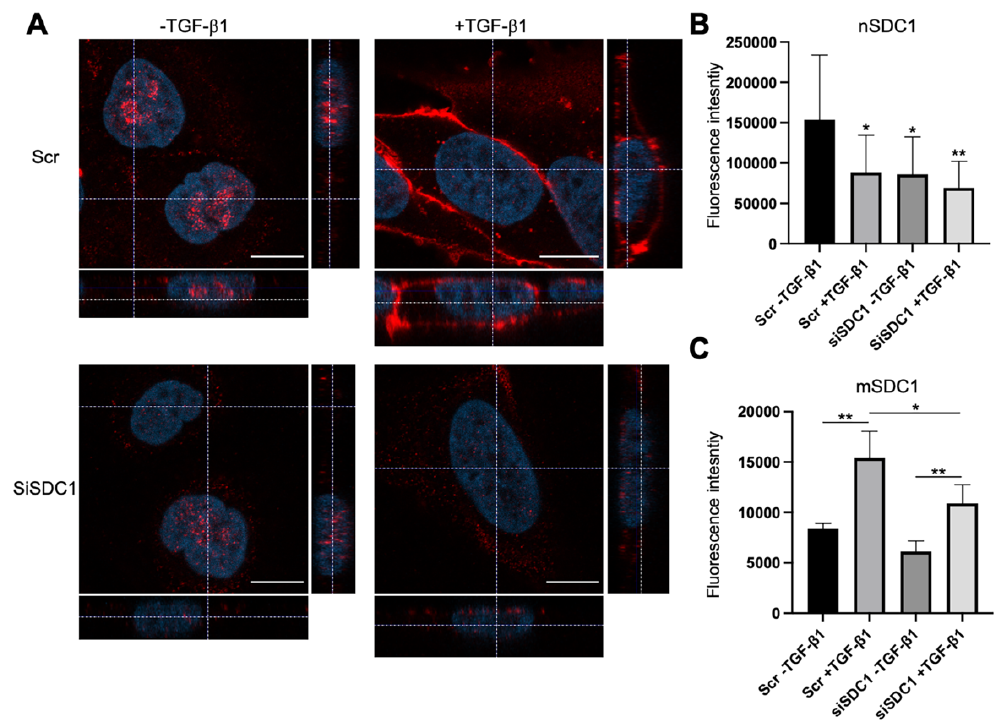
Figure 2. Loss of nuclear SDC1 during TGF- β 1-induced EMT in A549 cells. ( A ) Confocal immunofluorescent images showing staining and localization of SDC1 (red) in A549 cells transfected with Scr or SDC1 siRNA and either left untreated or treated with TGF- β 1 (10 ng/mL, 48 h). Cell nuclei were stained with DAPI (blue). Scale bars = 3 µ m. ( B , C ) Bar graphs showing fluorescence intensity of nuclear SDC1 staining (nSDC1, B) and membrane SDC1 staining (mSDC1, C) ( D ). * = p < 0.05; ** = p < 0.01.